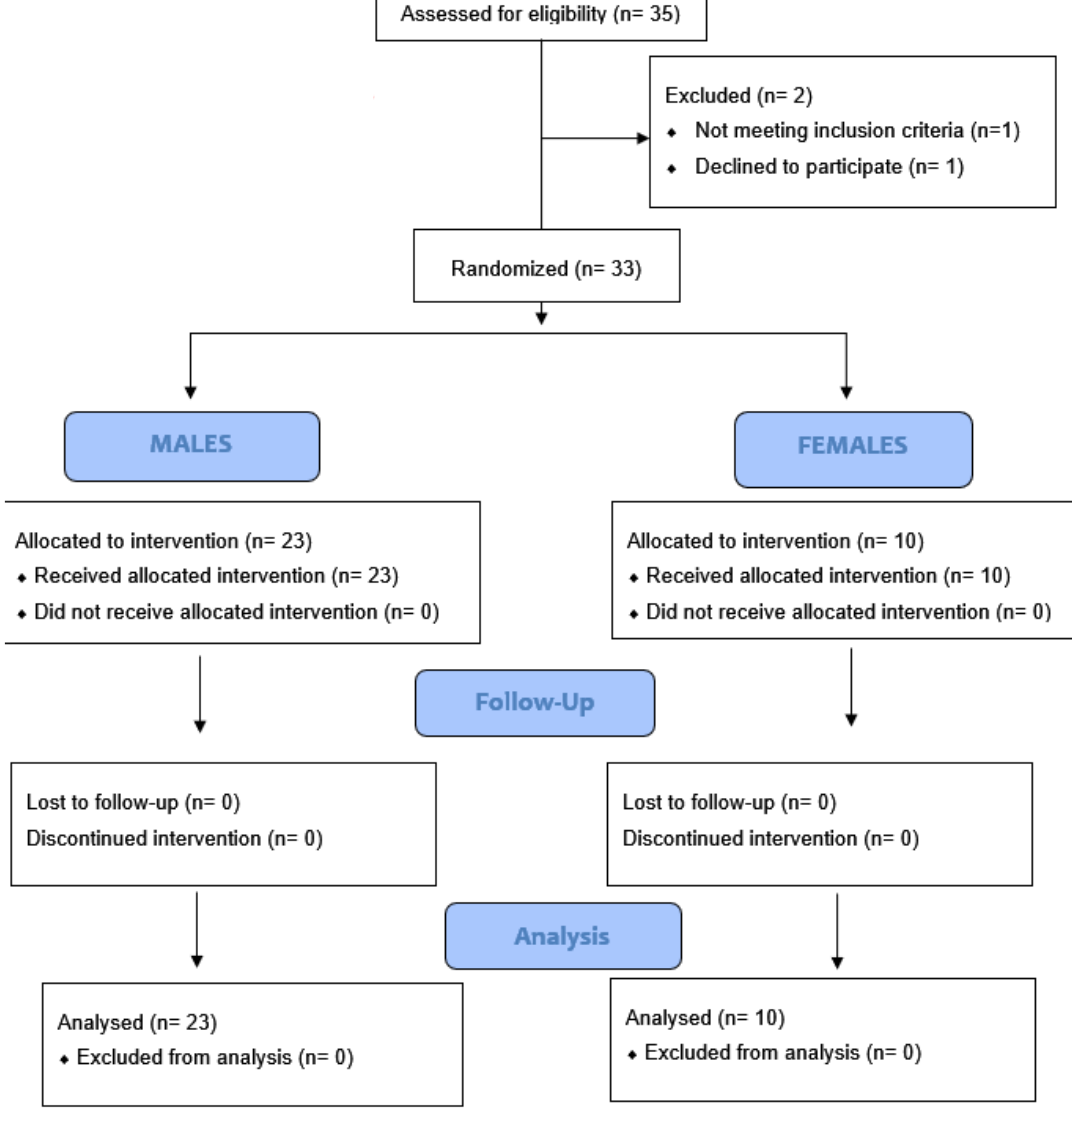
Scheme 1. CONSORT (Consolidated Standards of Reporting Trials) flow